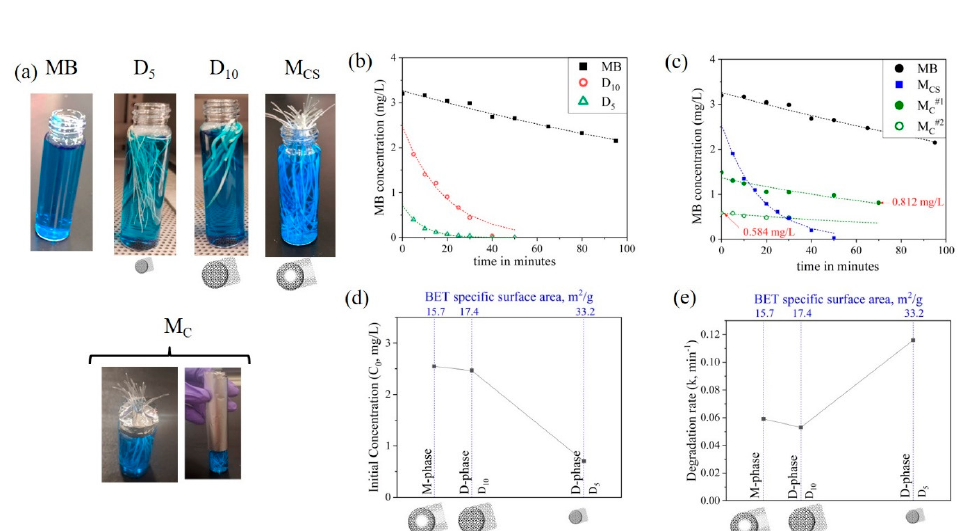
Figure 3. ( a ) Samples used for photocatalytic testing. Photocatalytic removal of methylene blue